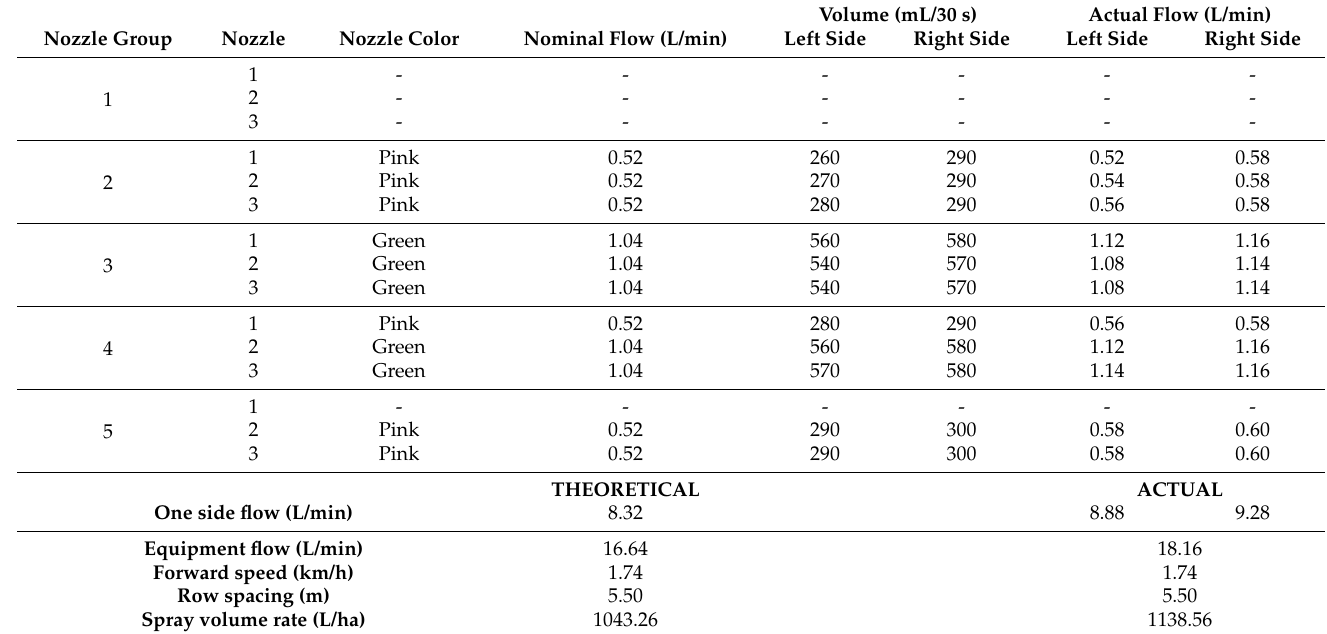
Table A5. Selection and calibration of nozzles for the T sprayer, with the following configuration: Adjusted to the vegetation/High & Low fan speed/Low spray volume rate/Drift-reducing nozzles (Coarse)/Pressure: 9 bar.